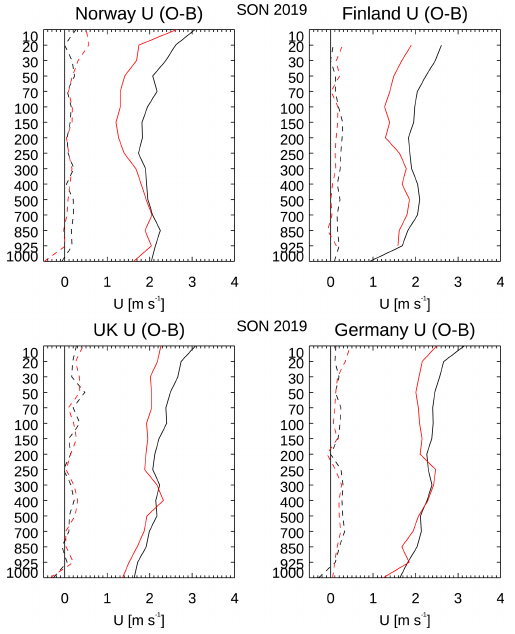
Figure 10. The u -component standard level statistics of the mean (dashed) and standard deviation (SD; solid) O − B differences for ascent (black) and descent (red) for four different countries for the period from September to November 2019.